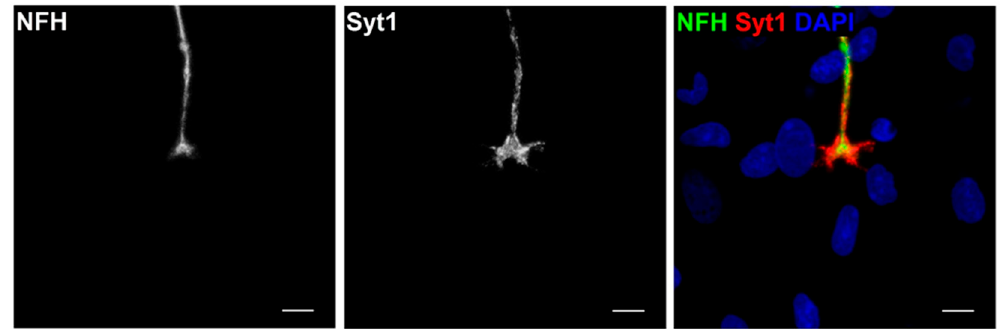
Figure 5. Characterisation of presynaptic neuromuscular junction activity at Day 14. Representative image of co-culture stained for neurofilament heavy (NFH) (green), synaptotagmin (Syt1) (red) and DAPI (blue). Scale bar = 7.5 µm.